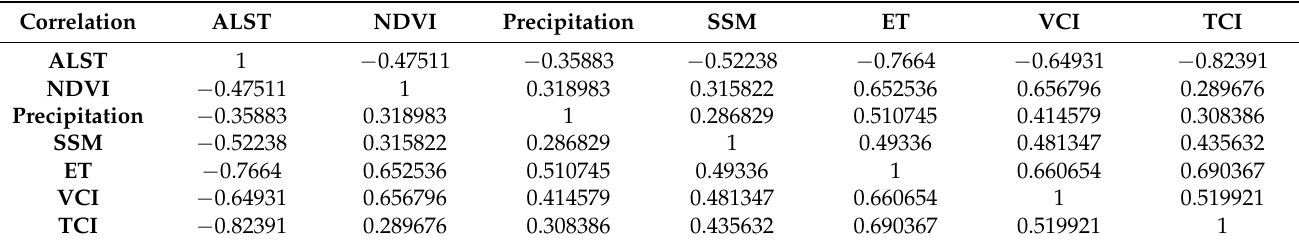
Table 8. Correlation between effective environmental factors of Sarbaz County.